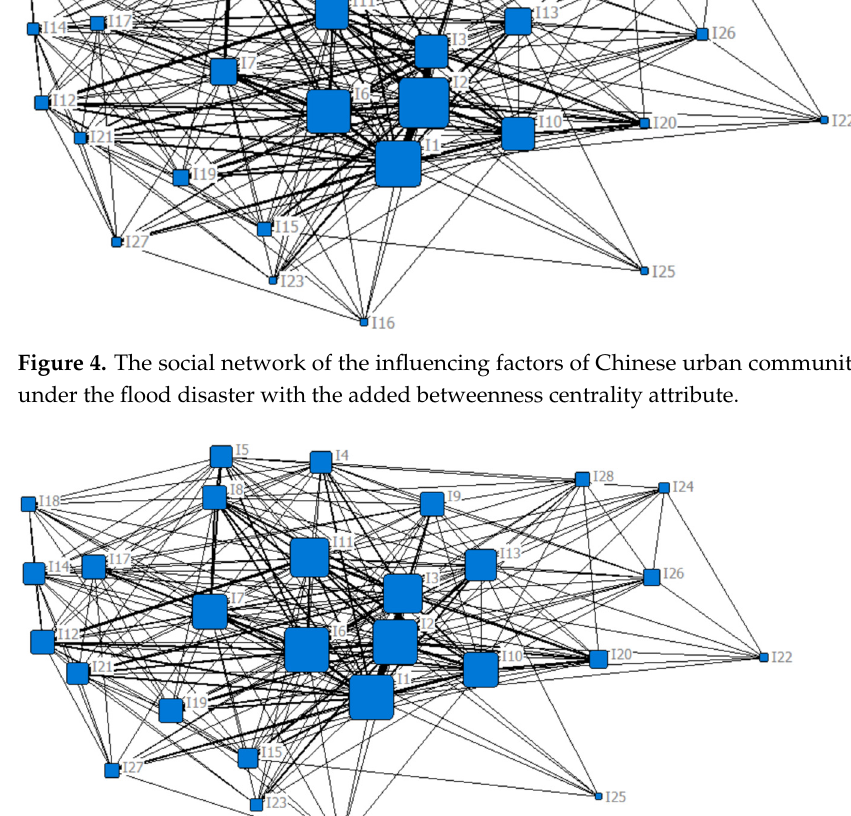
Figure 5. The social network of the influencing factors of Chinese urban community function loss under the flood disaster with the added closeness centrality attribute.